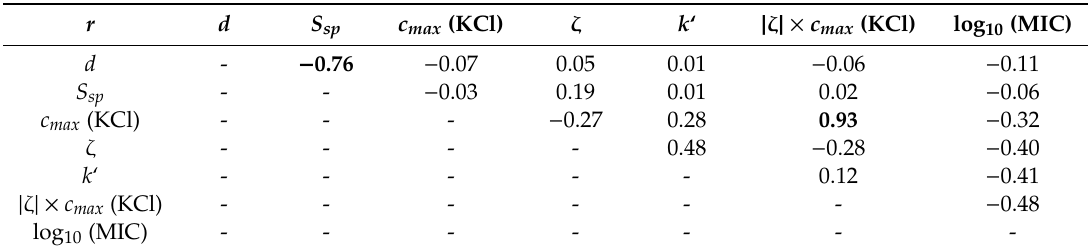
Table 4. Pearson linear correlation coe ffi cients ( r ) between silver NP dispersion descriptors and their toxicity for yeast cells; | r | > 0.5 are in